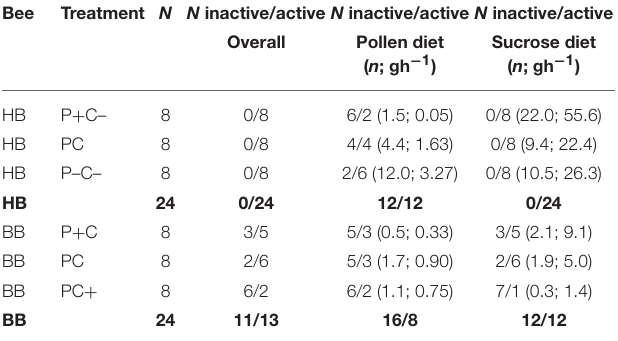
TABLE 2 | Active vs. inactive colony numbers.